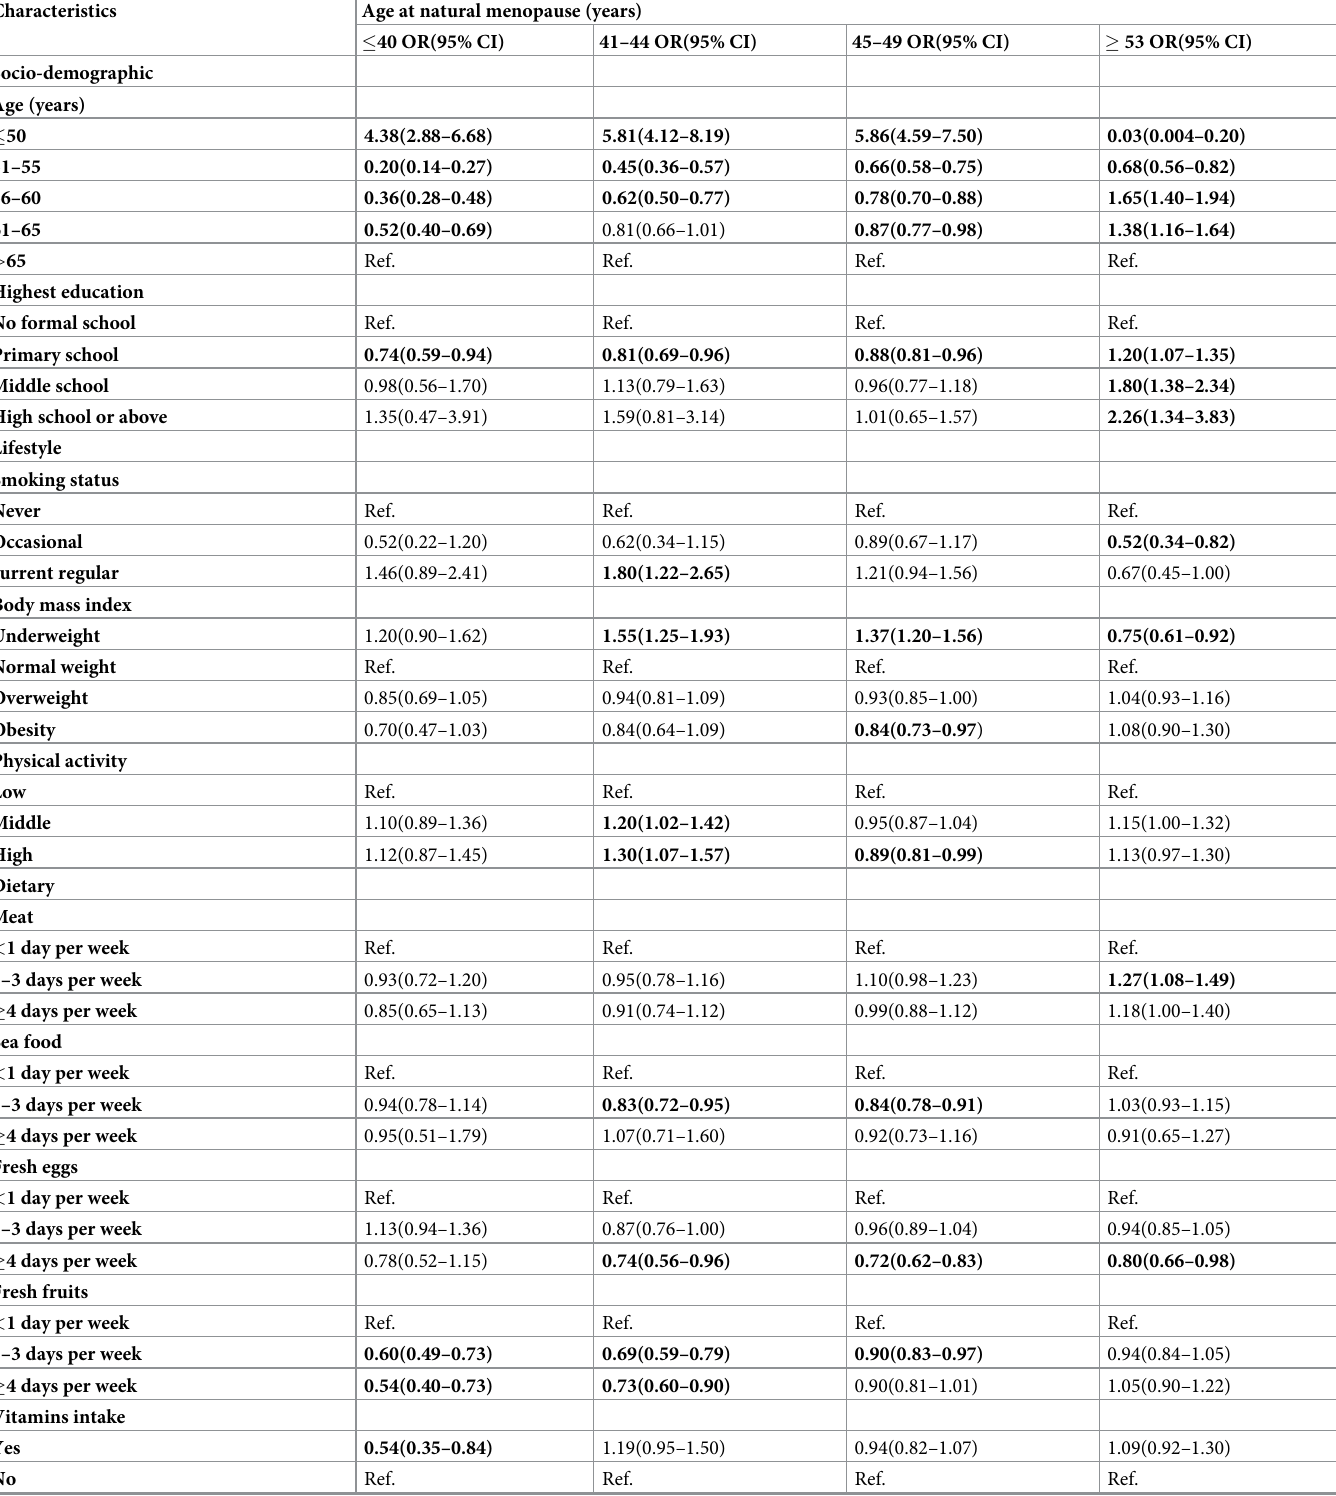
Table 5. Multinomial logistic regression- significant adjusted OR of characteristics and their association with age at natural menopause.